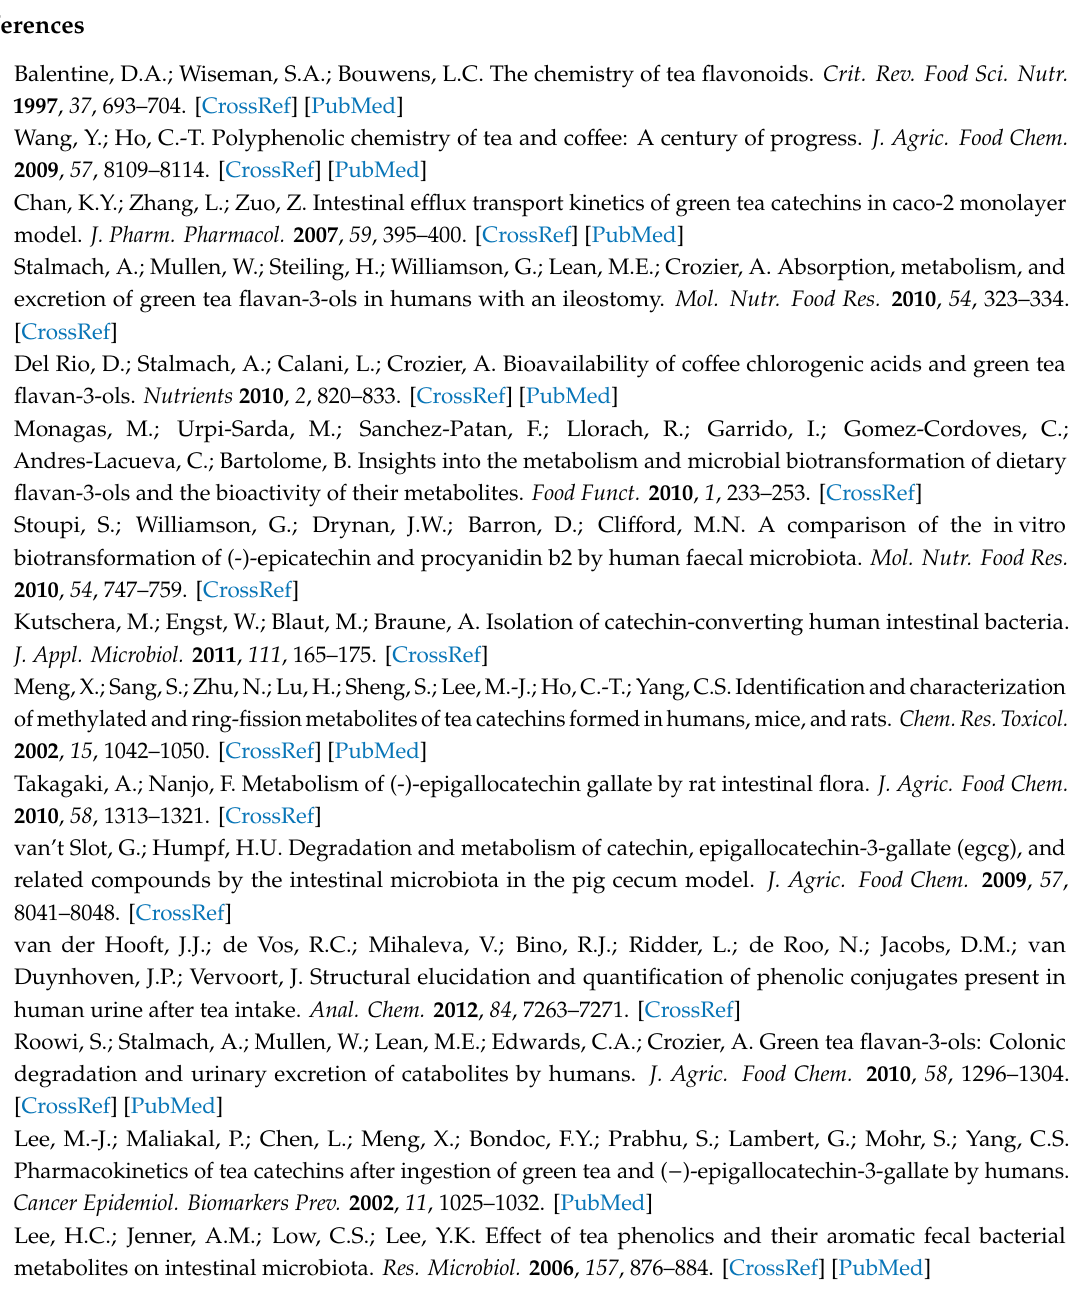
groups, Figure S1: The scores plot from a PCA model on fecal samples, Figure S2: Representative chromatogram of GTP-derived bacterial metabolites in human feces (A) and urine (B), Figure S3: The scores plot from a PCA model on urine